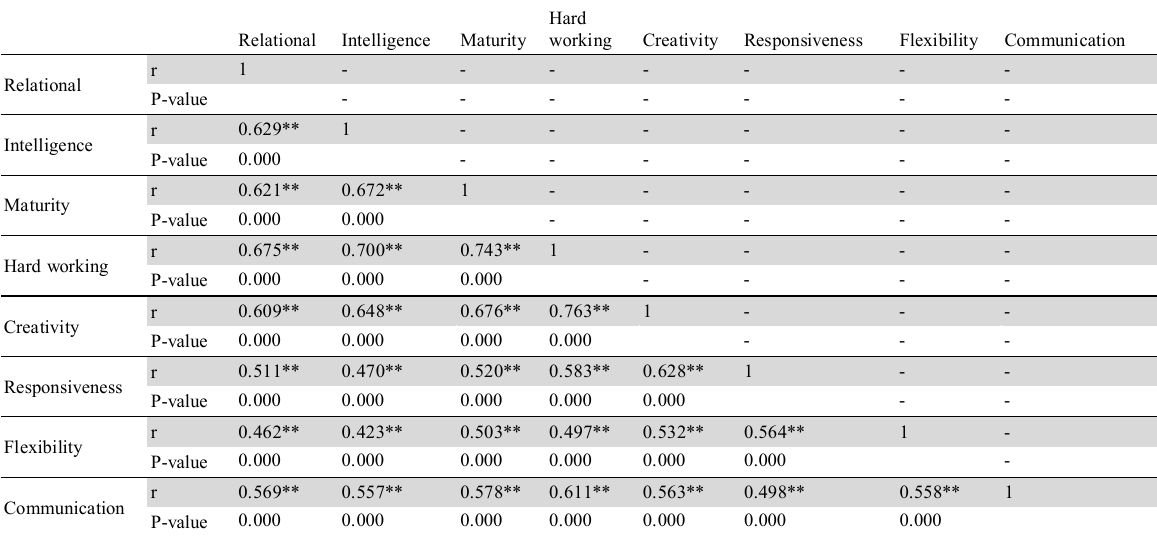
The summary of Pearson correlation test for workforce agility and relational components of knowledge